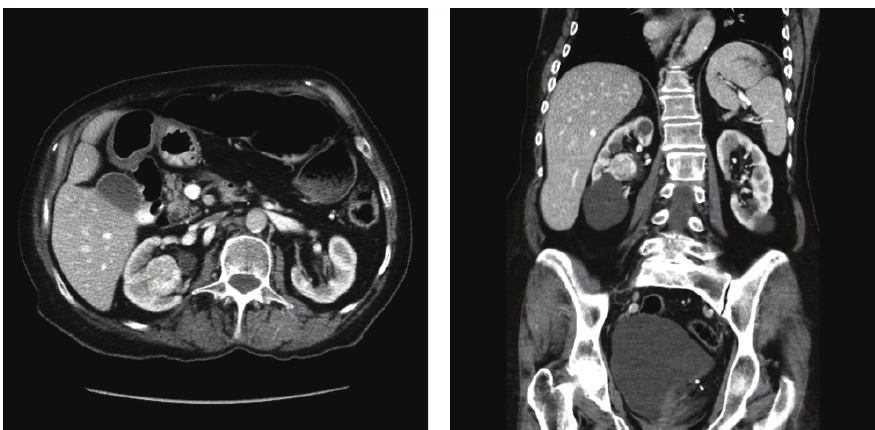
Figure 2: Axial and coronal infused CT imaging of patient